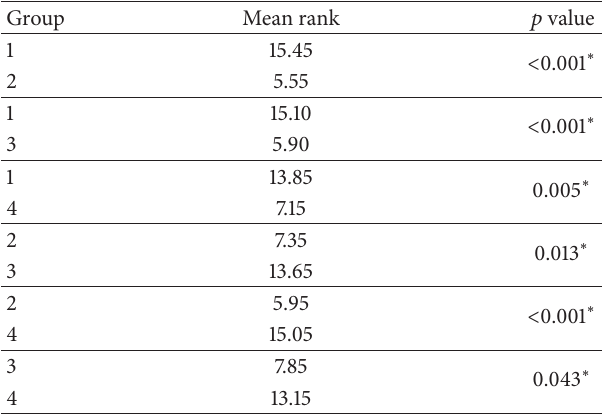
Table 3: Comparison of leakage in different groups using Mann- Whitney test.